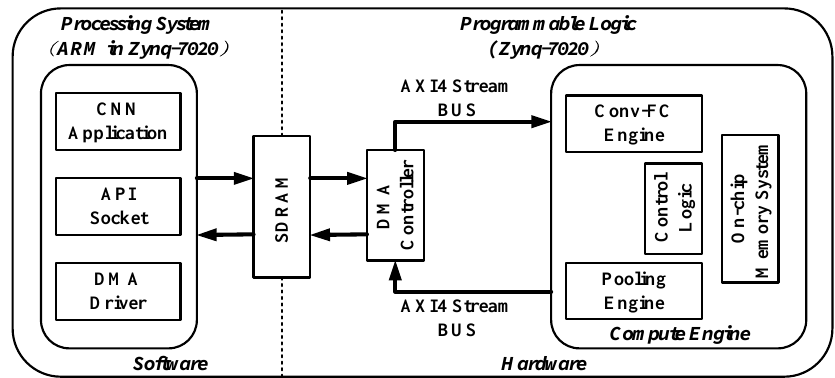
Figure 12. Field programmable gate array (FPGA) acceleration framework for malware traffic classification.